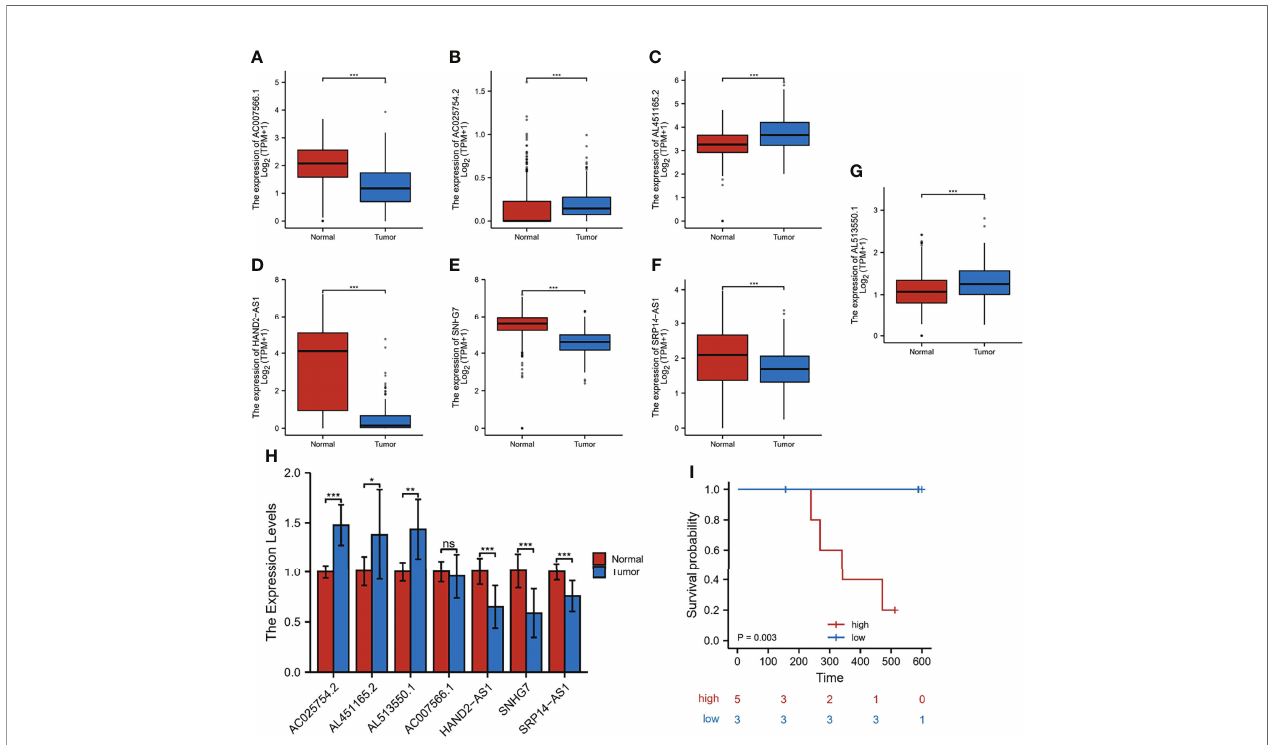
FIGURE 10 | Expression and validation of 7 m7G-lncRNAs. (A – G) The differential expression of 7 m7G-lncRNAs in ESCC samples compared to adjacent normal controls in TCGA and GTEx RNA-seq data. (H) RT-qPCR of the expression of the 7 m7G-lncRNAs in 10 pairs of clinical samples. (I) Risk grouping and survival difference analysis in 8 patients. * P < 0.05, ** P < 0.01, *** P < 0.001, ns, not signi fi